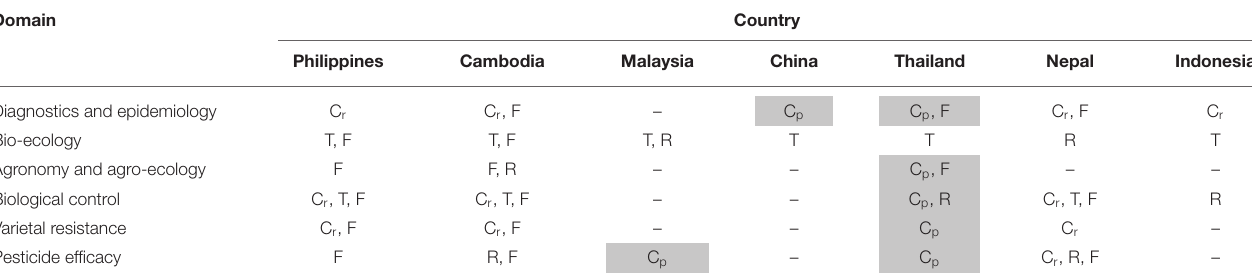
TABLE 3 | Mapping of tactical interventions in sustainable crop protection for seven Asia-Pacific countries. Domain Country